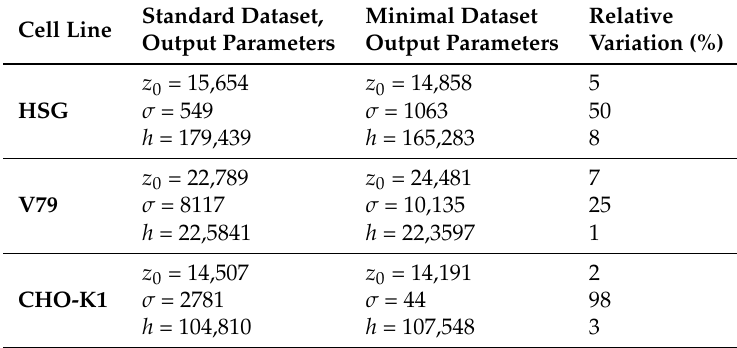
Table 4. Output parameters obtained by optimizing the lethal function of each cell line with the standard and minimal datasets; the relative differences are also